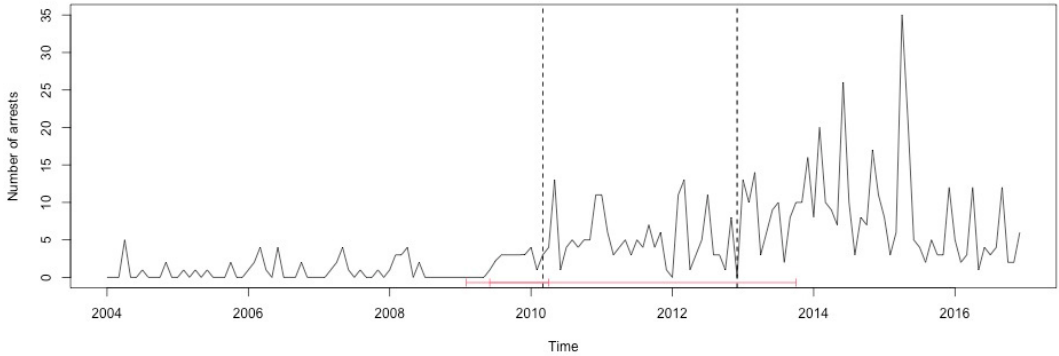
Figure A29. Methamphetamine Vietnamese nationals arrests 2004–2016 in the Czech Republic and structural breaks.